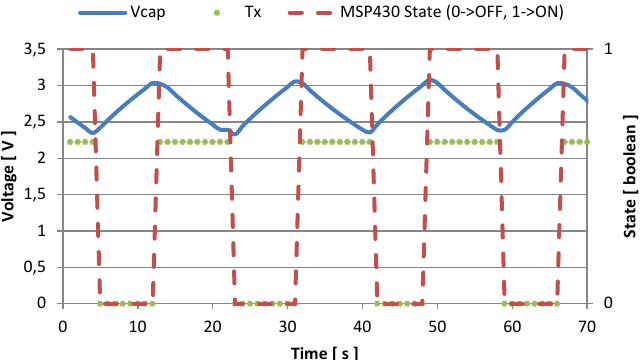
= 1.7 GHz, and CLK